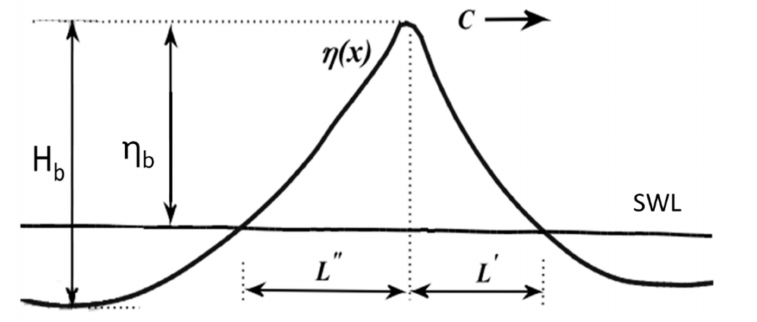
Figure 8. Definitions of local wave parameters [19].